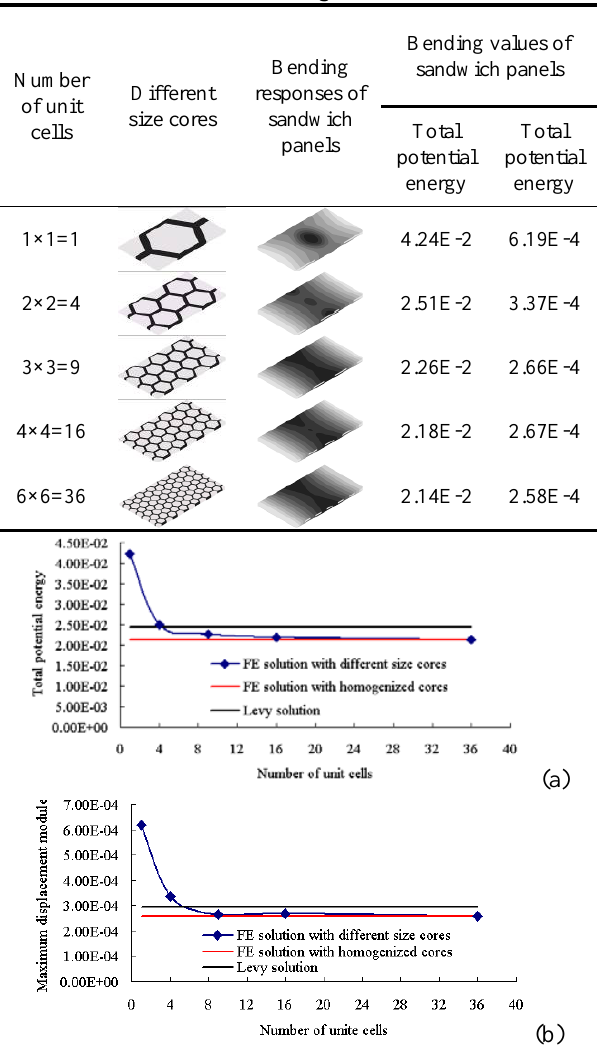
Fig.3. Levy solution of sandwich panel with homogenized cores